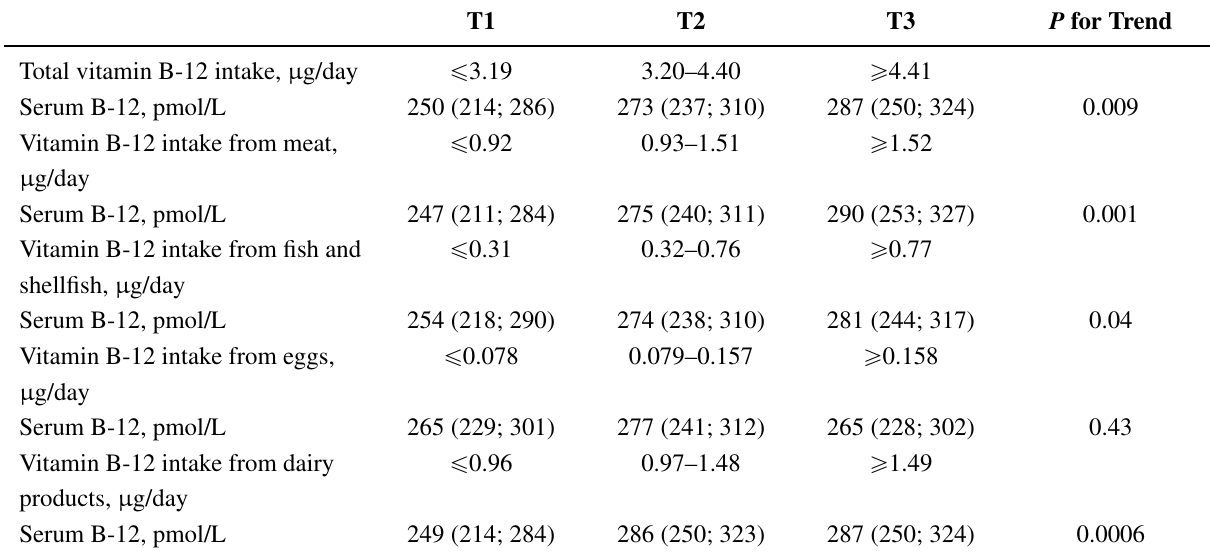
Table 3. Adjusted means and 95% CIs for serum vitamin B-12 concentrations by tertiles of vitamin B-12